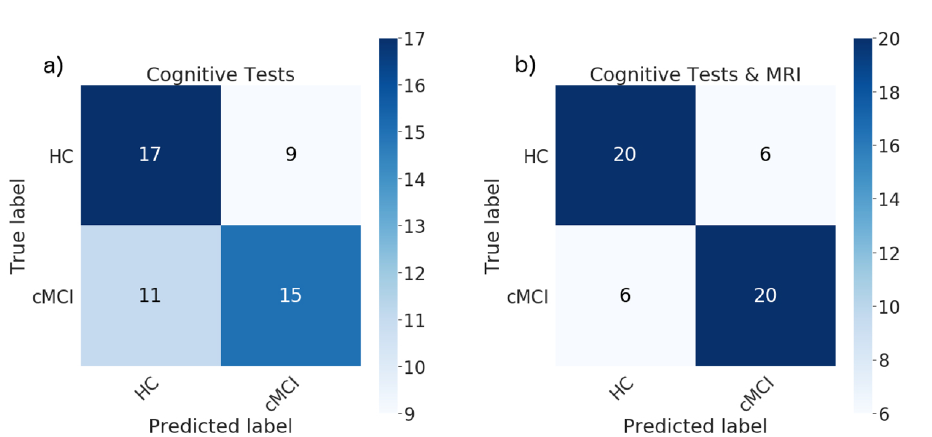
Figure 8. Confusion matrices for classifying HC vs. cMCI from cognitive features ( a ) and the combination of cognitive and MRI features ( b